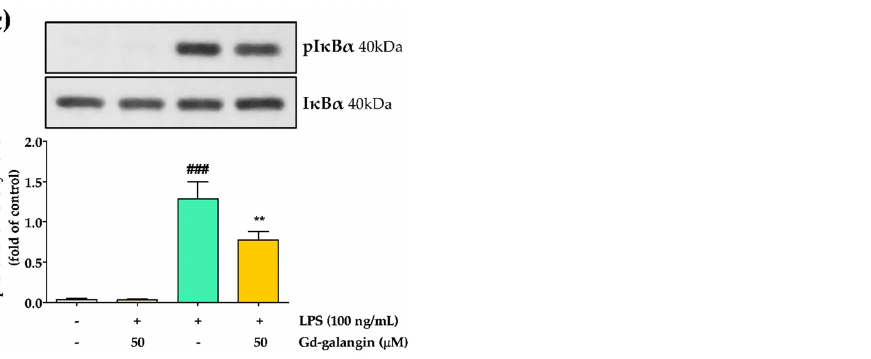
Figure 11. Effects of Gd-galangin on the nuclear transcription factor kappa B ( NF- κ B) signaling pathway. ( a , b ) Translocation of NF- κ B has been confirmed with nuclear extraction before perform- ing Western blot analysis. ( c ) Phosphorylation of nuclear factor of kappa light polypeptide gene enhancer in B-cells inhibitor (I κ B α ) has been developed at the cytosol level of RAW 264.7 cells. (Data are shown as the mean ± SEM, t -test, n ≥ 3. # p < 0.05, ## p < 0.01, ### p < 0.001 compared to control group; * p < 0.05, ** p < 0.01 compared to LPS-stimulated group).